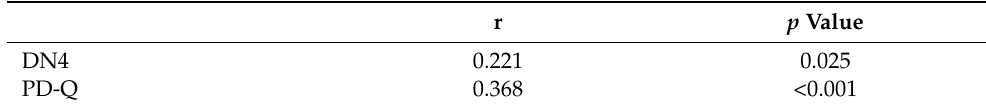
Table 2. Correlation between DN4 or PD-Q score and NDI score in patients with cervical radicular pain. r p Value DN4 0.221 0.025 PD-Q 0.368 <0.001